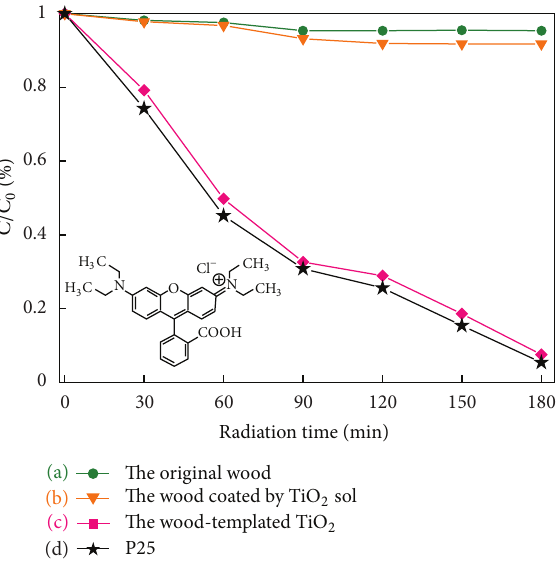
Figure 6: Photocatalytic activity of (a) the original wood, (b) the wood coated by TiO 2 sol, (c) the wood-templated TiO 2 , and (d) P25,